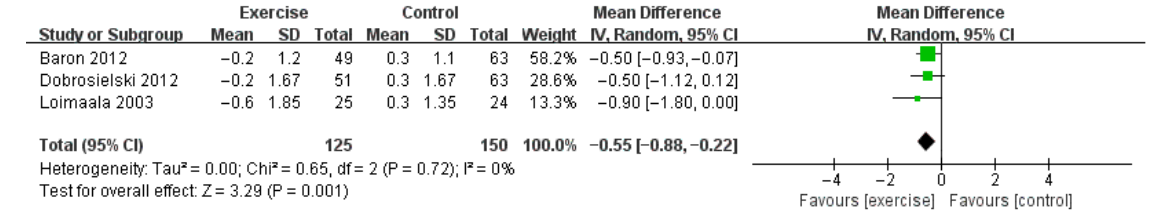
Figure 5. The pooled result of the difference of changes in systolic blood pressure between two groups [35 – 38].